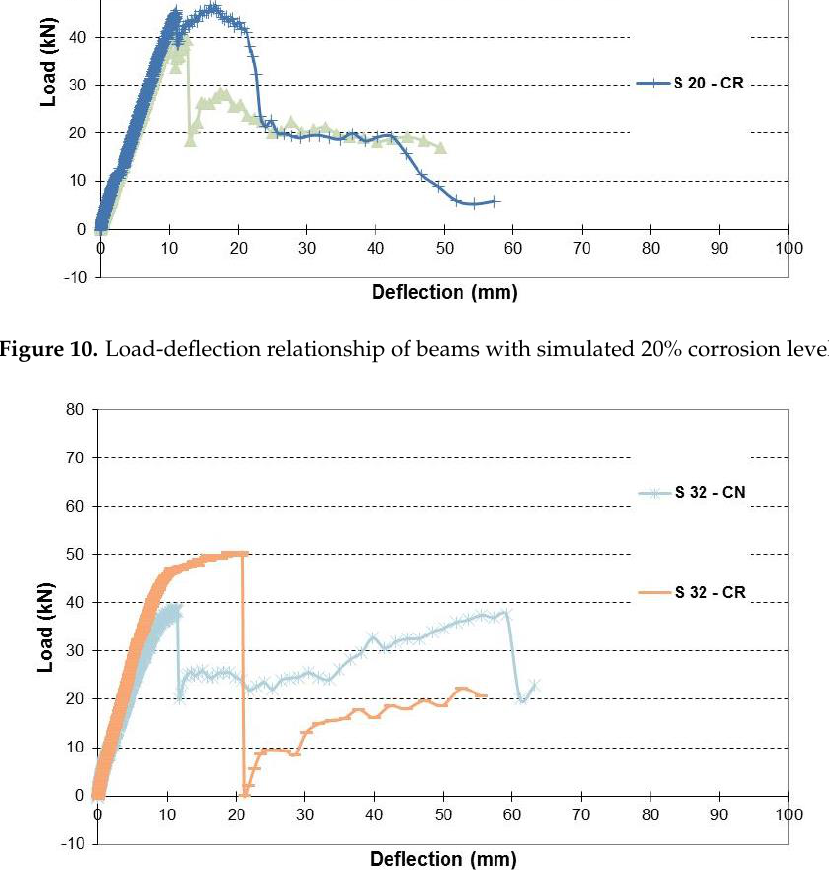
Figure 11. Load-deflection relationship of beams with simulated 32% corrosion level.